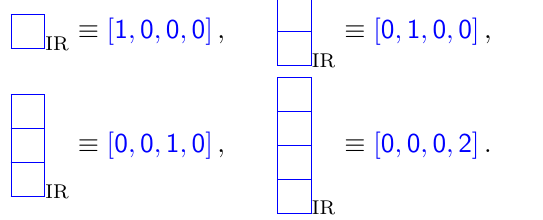
Tableau is composed of a columns of one box, b columns of two vertical boxes, c columns of three vertical boxes, and d/ 2 columns of four vertical